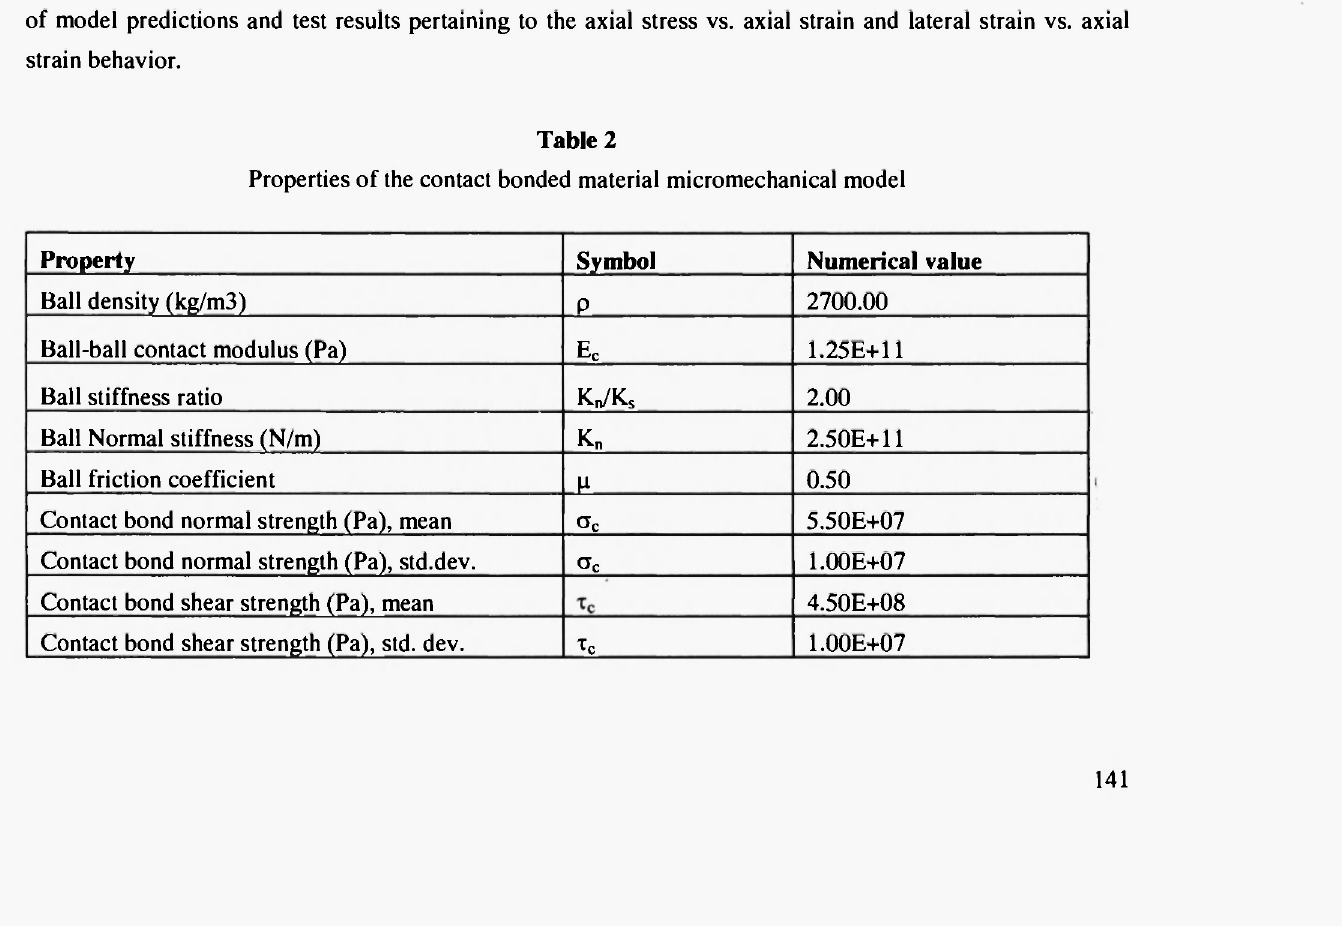
Fig. 9: (a) Apparent Young's modulus, and (b) apparent Poisson's ratio as a function of the stiffness ratio Ks/K